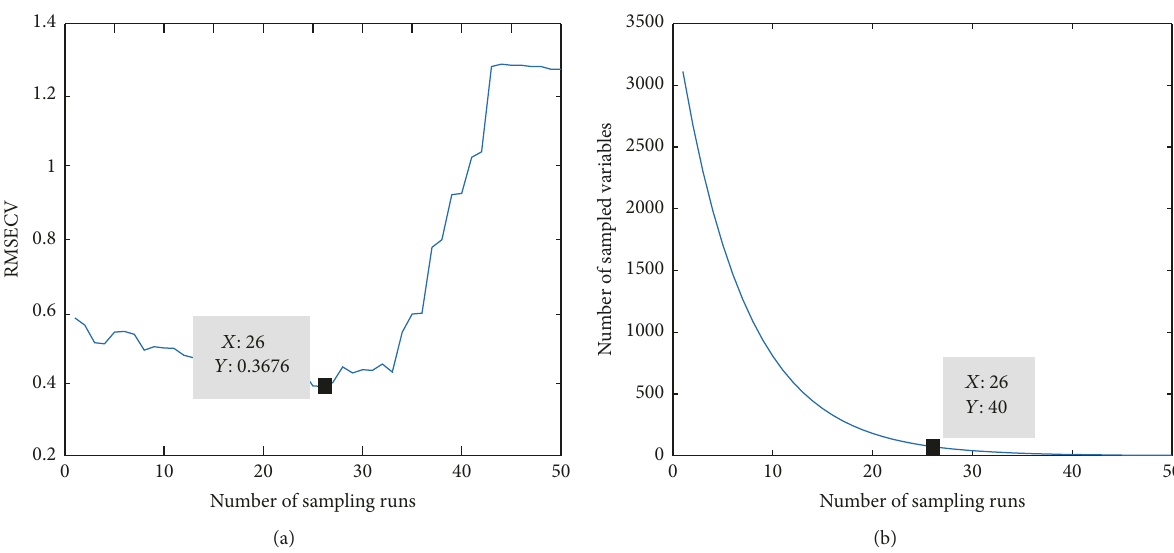
Figure 8: The 10-fold RMSECV values (a) from one CARS running and the changing trend of the number of sampled variables (b) with the increasing of sampling runs.